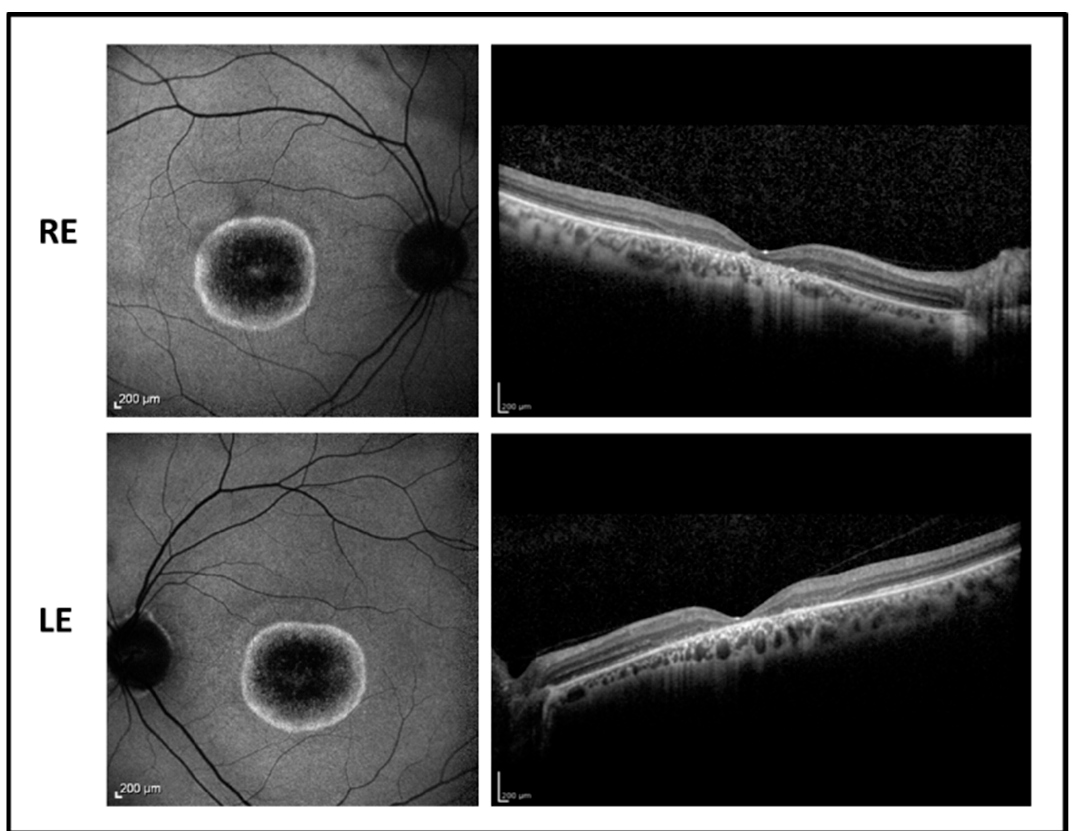
Figure 3. Fundus autofluorescence ( left side ) and OCT ( right side ) images of the right eye (RE) and left eye (LE) of patient 2 showing central hypofluorescence with hyperfluorescent perifoveal ring and marked reduction of foveal thickness with photoreceptor defect.